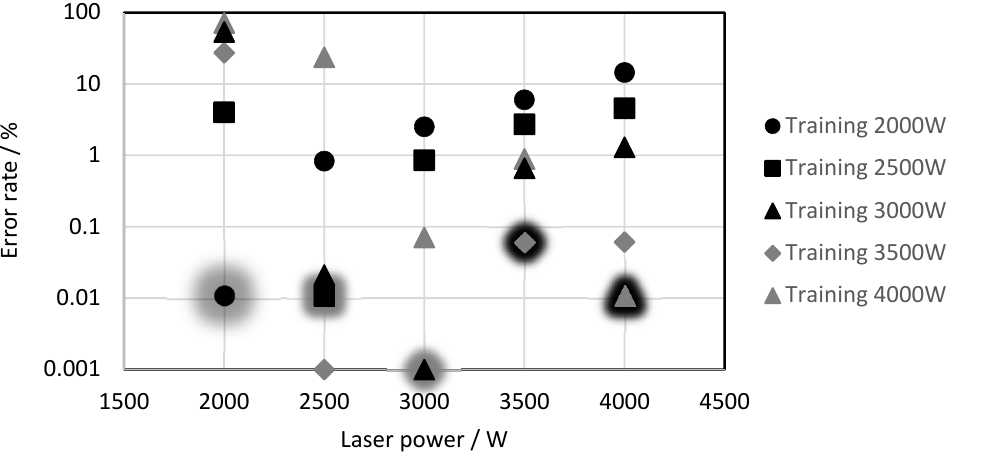
Figure 8. Error rate as a function of the laser power.